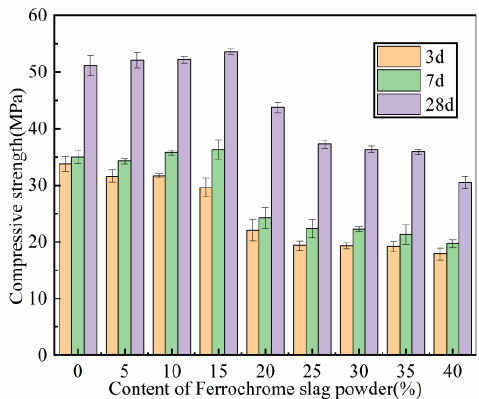
Figure 8. Compressive strength of cement mortar.